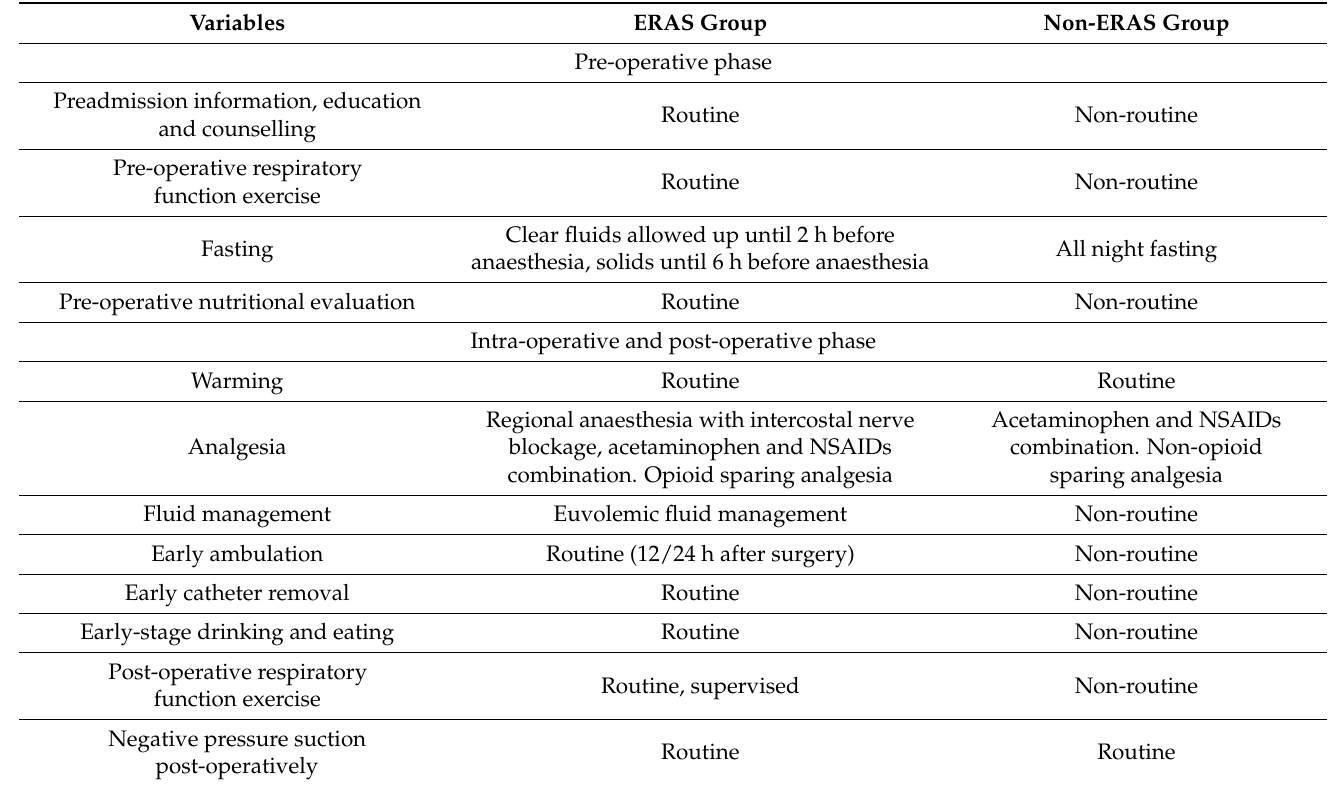
Table 1. Comparison between the ERAS group and non-ERAS